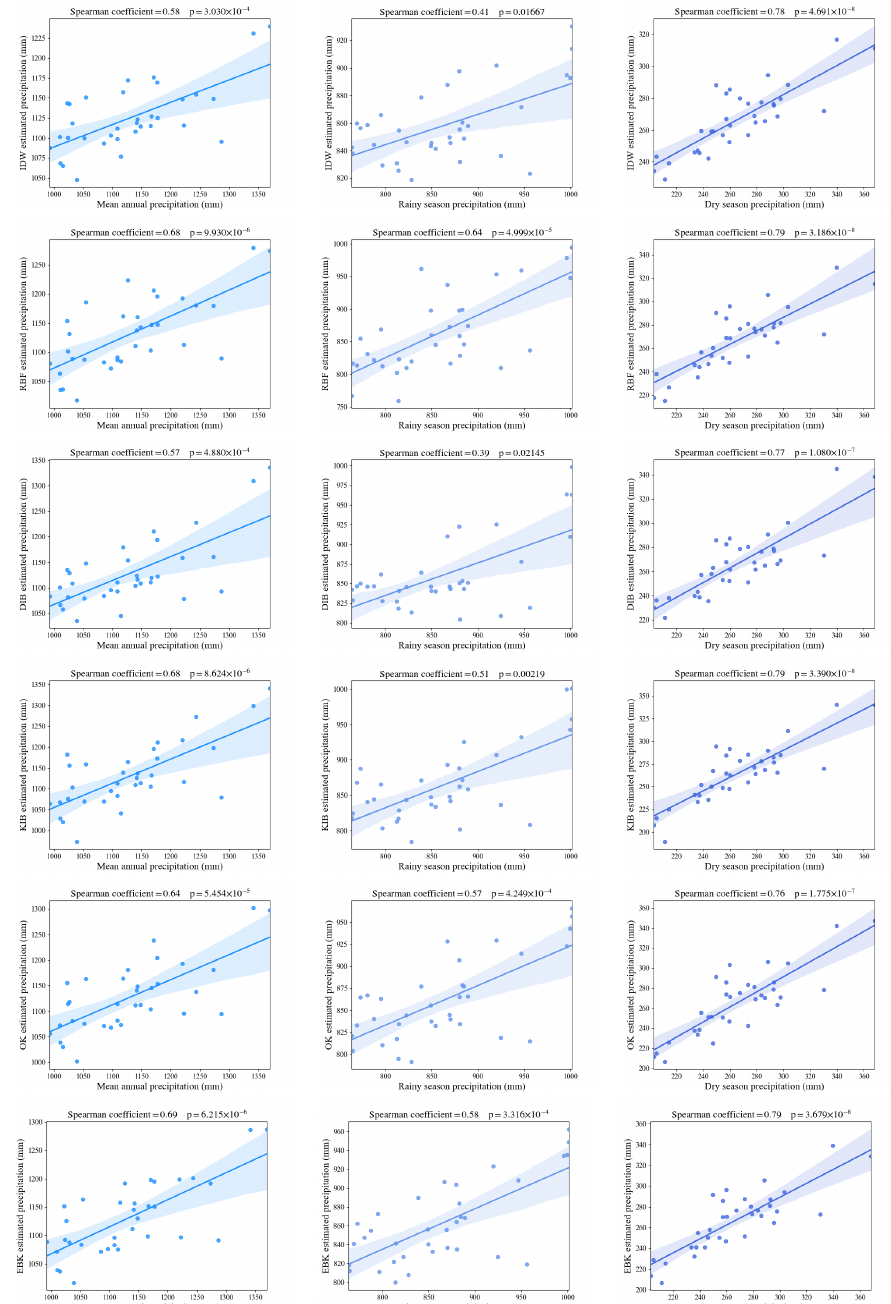
Figure 6. Correlation test and Spearman coefficients between estimated and observed values based on six interpolation methods (IDW, RBF, DIB, KIB, OK, EBK): ( a ) mean annual; ( b ) rainy season; and ( c ) dry